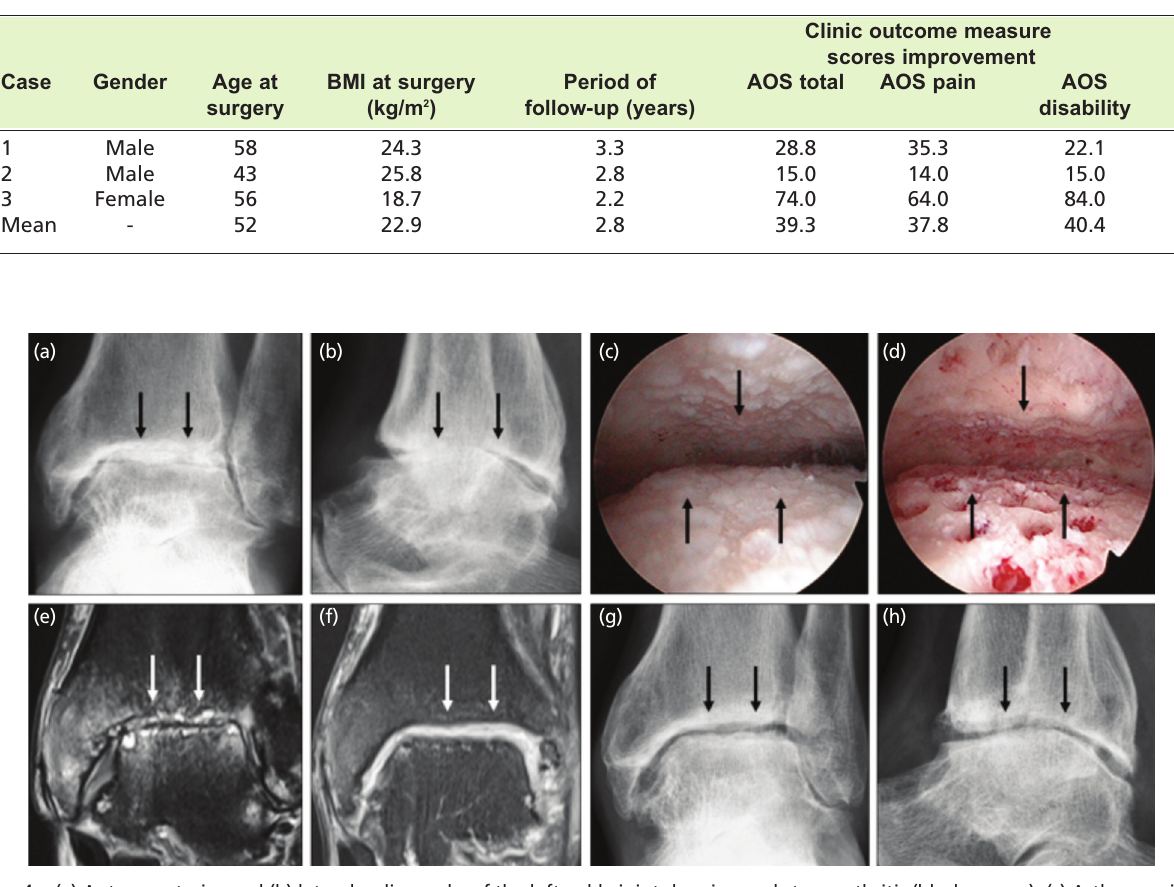
(a) Anteroposterior and (b) lateral radiographs of the left ankle joint showing end-stage arthritis (black arrows). (c) Arthroscopic Fig. 1: view of the left ankle joint showing diffuse bone-on-bone cartilage loss (black arrows). (d) View after arthroscopic subchondral drilling of almost the entire ankle joint (black arrows). (e) Coronal MR image showing advanced arthritic changes (white arrows). (f) MR image at two years following chondrogenesis with satisfactory cartilage thickness on both articular surfaces (white arrows). (g, h) Radiographs at two years showing reappearance of the ankle joint space (black arrows). The MR images are fat- suppressed proton density-weighted.